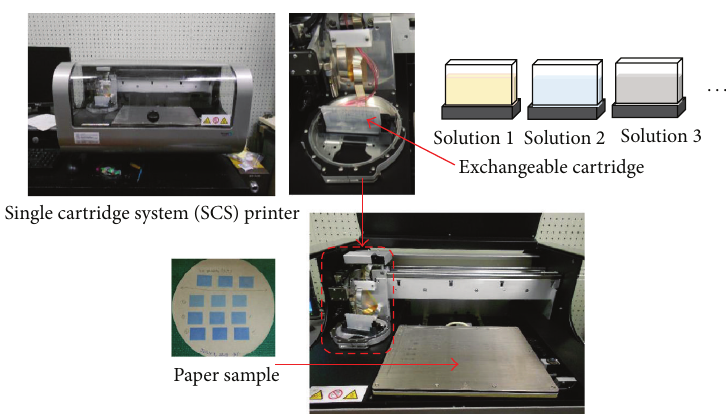
Figure 3: Medium printing by SCS printer sequence.